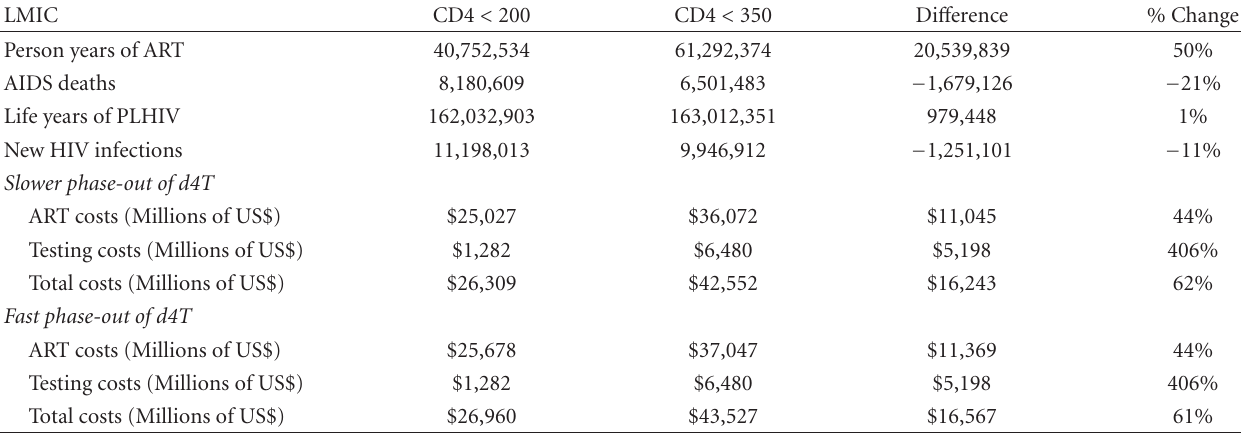
Table 3: Global results when ART eligibility is switched from CD4 count < 200 to CD4 count < 350 in 2010 while increasing coverage to 80% by 2015, by di ff erent d4T phase-out scenarios